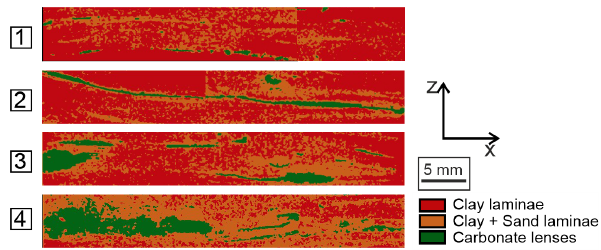
Figure 1. Four structures of SF-OPA with different subfacies com- positions. The four cases show the different structure types with a low concentration of carbonate lenses (S1), single layer (S2), and a high concentration of carbonate lenses (S3 and S4). Figure is mod- ified after Yuan and Fischer